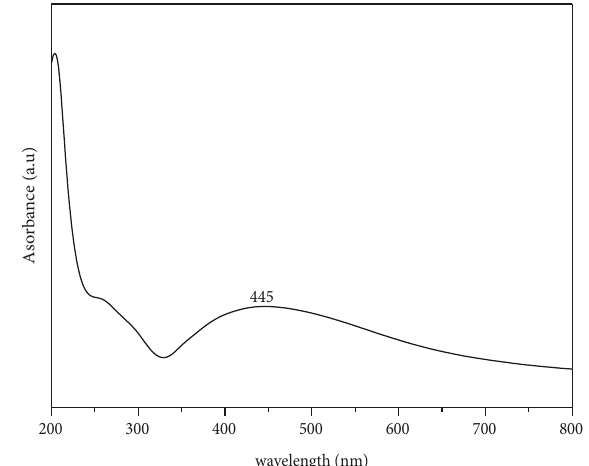
Figure 2: UV-visible spectra of synthesized silver nanoparticles using the Pisonia Alba leaf extract.